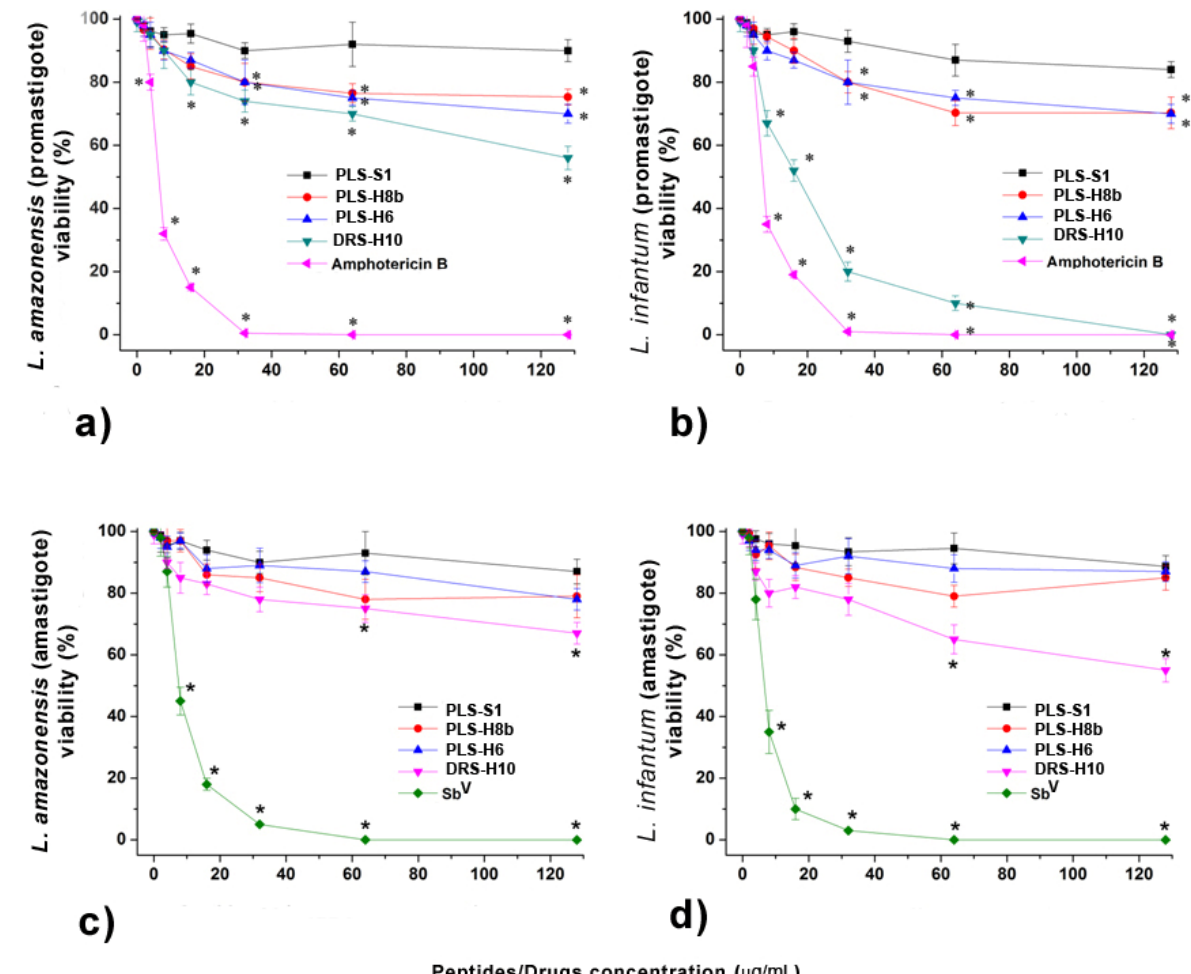
Figure 3. Percentage of living Leishmania (L.) amazonensis ( a ) and L. infantum ( b ) promastigotes incubated with different concentrations of peptides or amphotericin B for 6 h. Percentage of living Leishmania (L.) amazonensis ( c ) and L. infantum ( d ) amastigotes incubated with different concentrations of antimicrobial peptides and SbV (Glucantime ® ) for 6 h. Schneider medium was used as control. All data are represented by the mean value and standard deviation. (*) p < 0.05 when compared to the